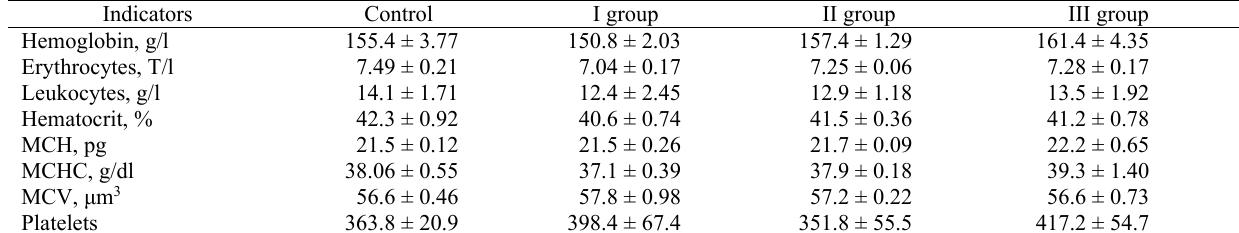
Hematological indicators of the blood of white rats for the study of toxicity by the classic method (M ± m, n = 5) Indicators